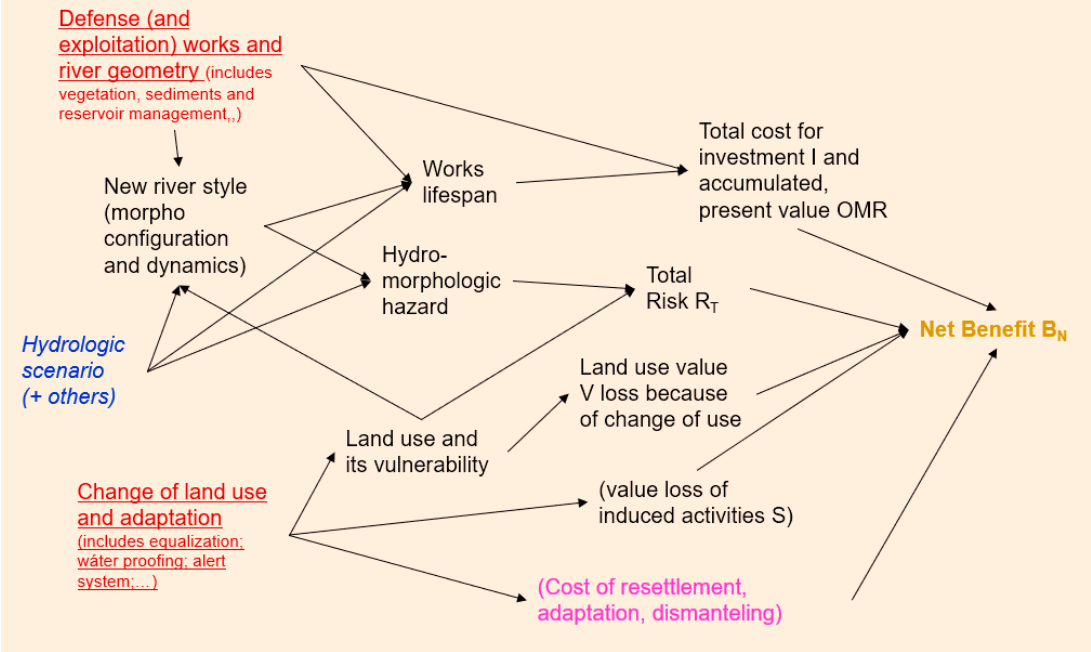
Figure 11. A scheme to carry out the CBA supporting the design exercise.